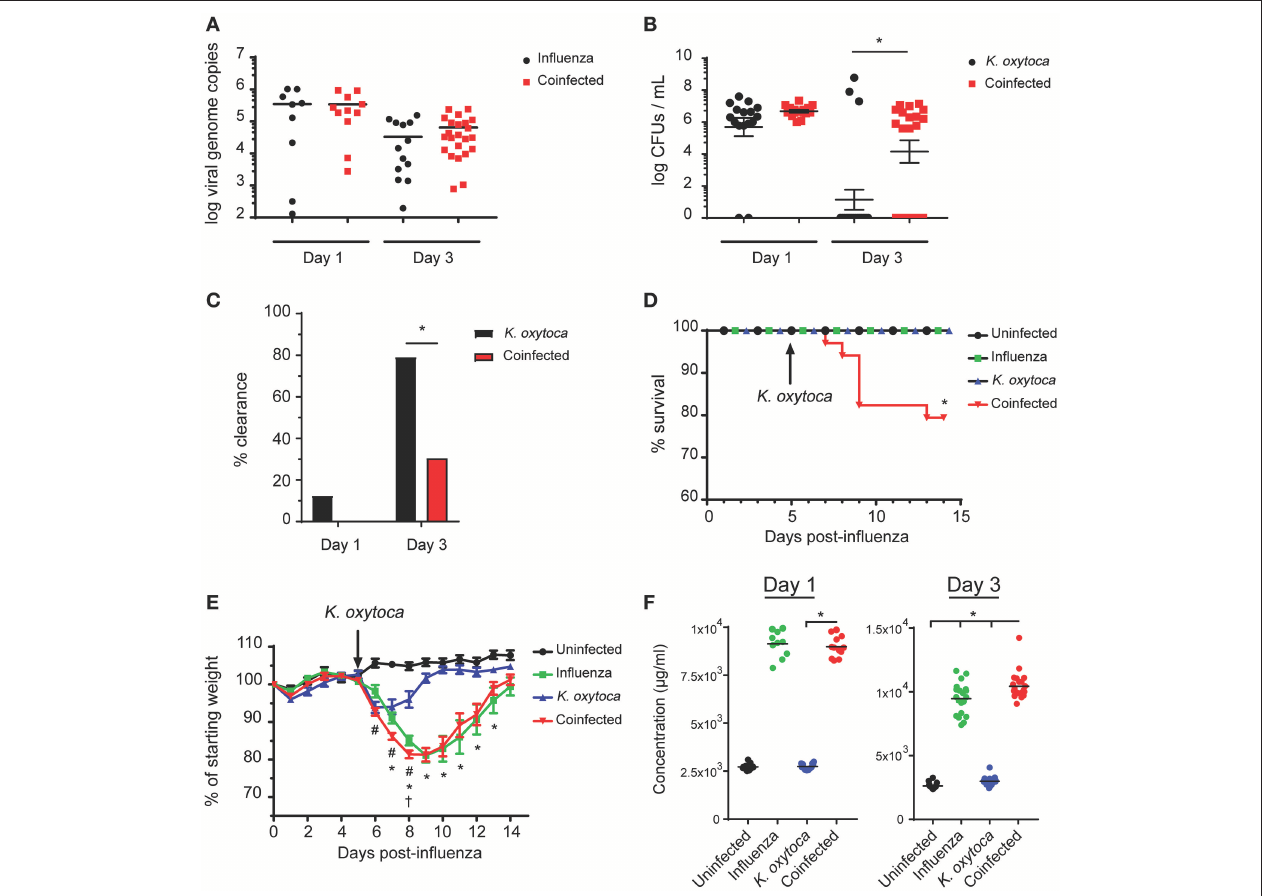
FIGURE 4 | Coinfected mice exhibit increased morbidity and mortality as well as decreased resistance and tolerance . Viral burden as measured by viral genome copies in lung tissue on days 1 and 3 (A) . Bacterial burden as measured by colony-forming units (CFUs) in 1mL of lung homogenate on days 1 and 3 (B) . Percentage of mice with no detectable bacteria in their lungs at day 1 and 3 (C) . Survival of naïve, singly-infected and coinfected mice was measured over the course of 2 weeks (D) . Weights were monitored during this time and are expressed as percentages of the starting weight of each mouse prior to infection (E) . Concentration of albumin in the BALF on days 1 and 3 post- K. oxytoca (F) . In (E) # denotes P ≤ 0.05 between coinfected and IAV groups while * denotes P ≤ 0.05 between coinfected and K. oxytoca groups. † denotes day at which coinfected mice begin to exhibit decreased survival. In (C,D,F) * denotes P ≤ 0.05 between indicated groups. Data